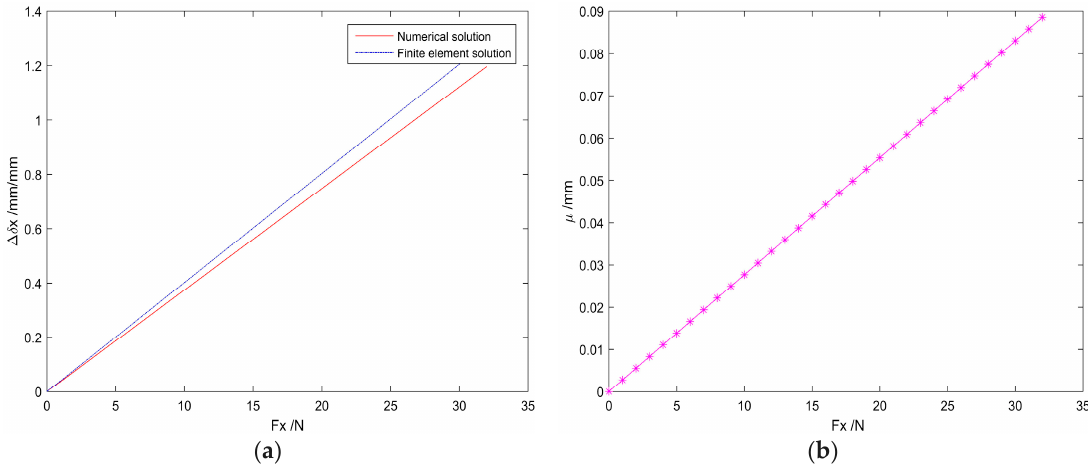
Figure 7. Deformation of the mobile platform that is obtained by analytical and numerical methods: ( a ) displacement along the x -axis under load; ( b ) displacement difference along the x -axis under load.